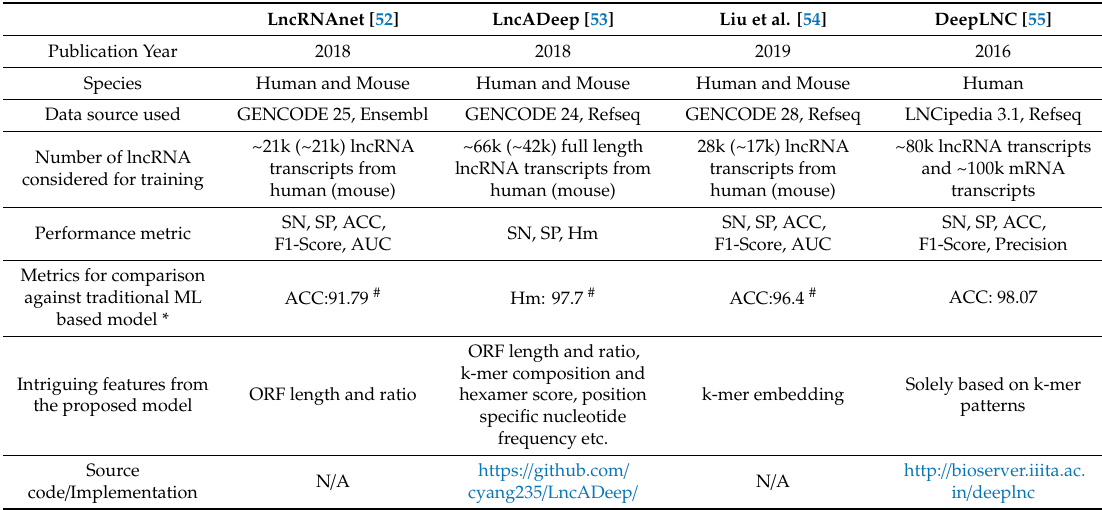
Table 2. Overview of articles for lncRNA identification leveraging DL-based